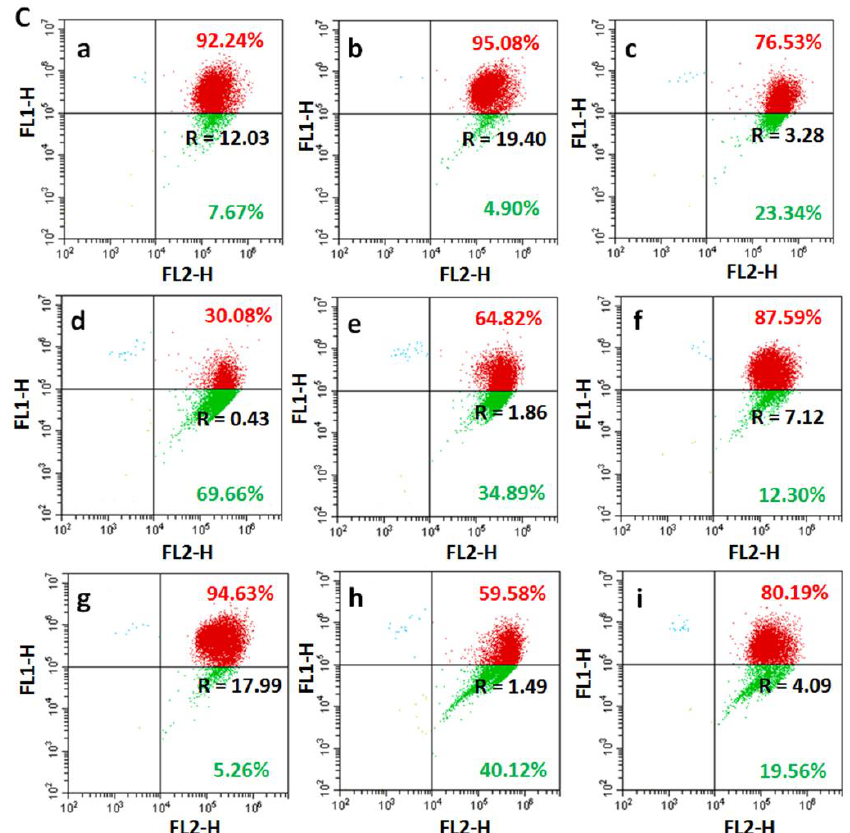
Figure 9. ( A ) The complexes locate at the mitochondria. ( B ) Assays of the changes of mitochondrial membrane potential after SGC-7901 cells (control, a) exposure to CCCP (b, positive control), 1 (4.0 µ M) (c), 2 (15.0 µ M) (d), or 3 (15.0 µ M) (e) for 24 h. ( C ) The ratio of red / green fluorescence intensity (R) after SGC-7901 cells were exposed to 4.0 µ M 1 , 15.0 µ M 2 or 3 in the absence or presence of NAC for 24 h: SGC-7901 (a), SGC-7901 + NAC (b), CCCP (c), 1 (d), 1 + NAC (e), 2 (f), 2 + NAC (g), 3 (h), 3 + NAC (i).